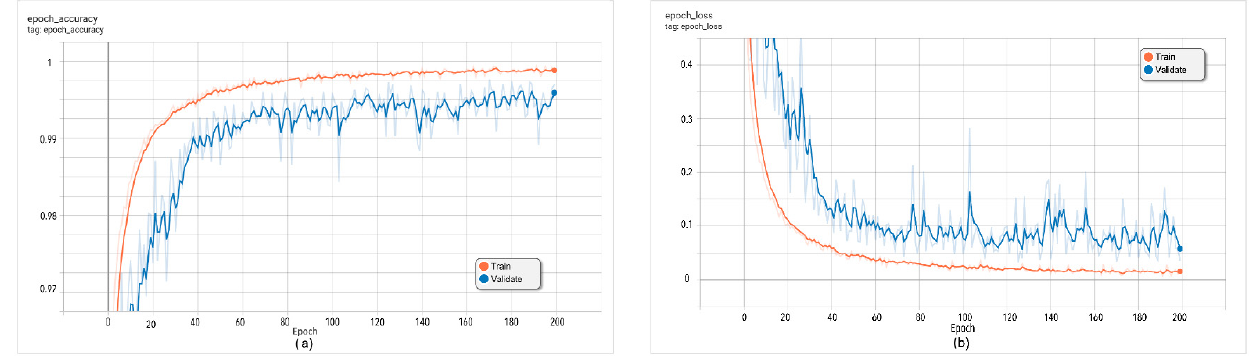
Figure 4. Results obtained for k-folds.